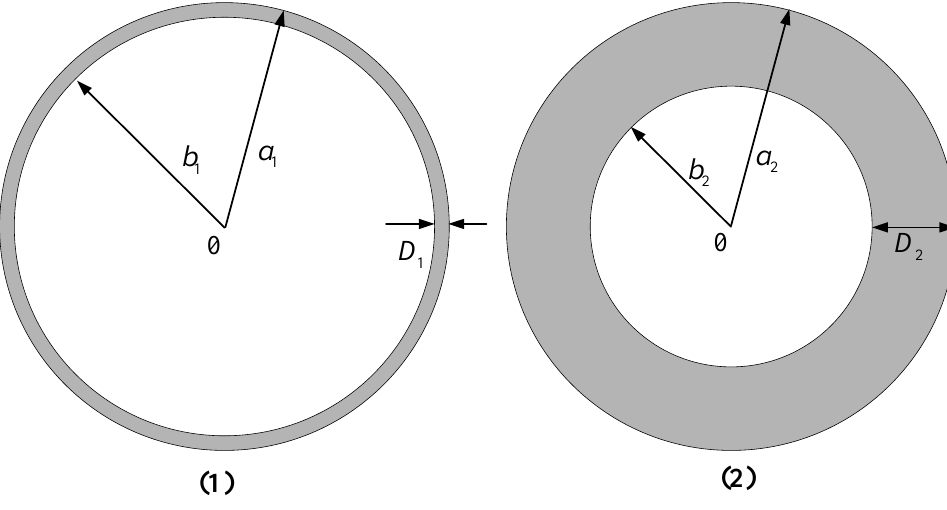
Figure 10. Magnetoacoustic signal simulation model. The electromagnetic excitation is applied to the ring model, and the ring generates a magneto-acoustic signal through an electromagnetic coupling effect. When the scanning radius is, the magneto-acoustic signal acquired waveform as shown in Figure 11.